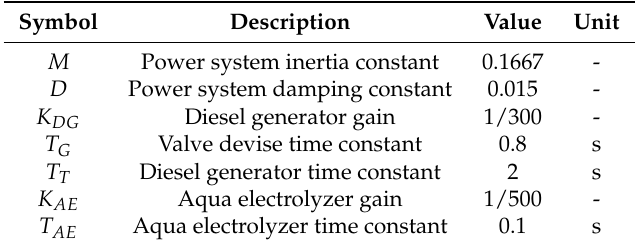
Table 1. System, DG and AE model parameters used for